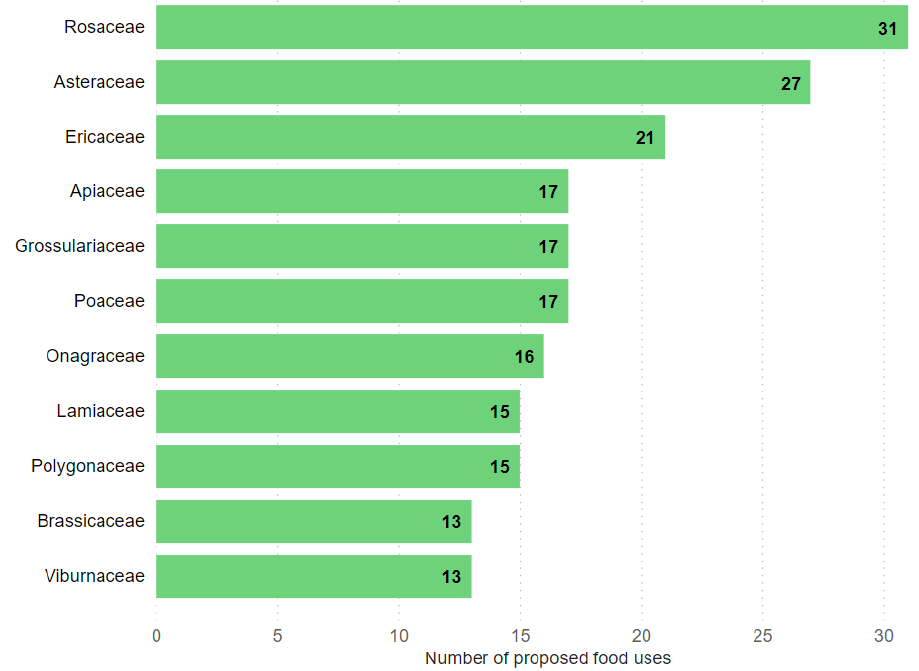
Figure 1. The top 11 plant families according to the number of proposed food use categories in all 12 books published centrally in Russian during the Soviet era.